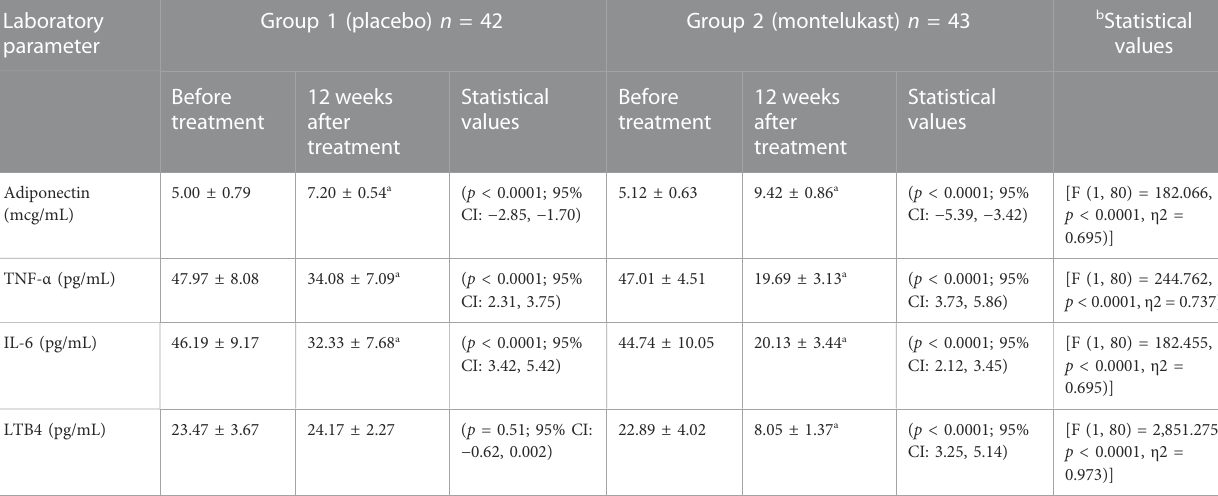
TABLE 3 Biochemical parameters of the two study groups before and after 12 weeks of